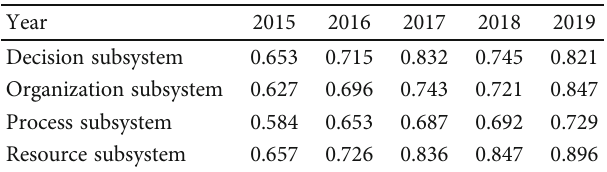
Table 8: Order degrees of the CME management synergy subsystems in Henan